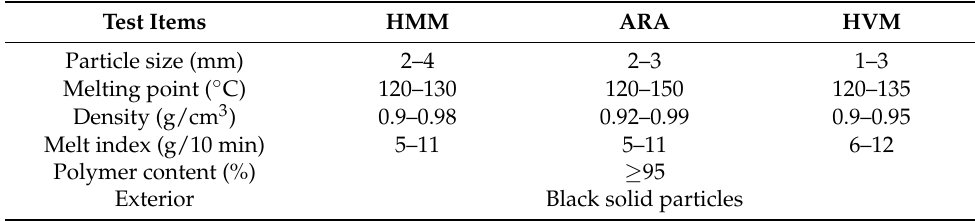
Table 2. Properties of SBS